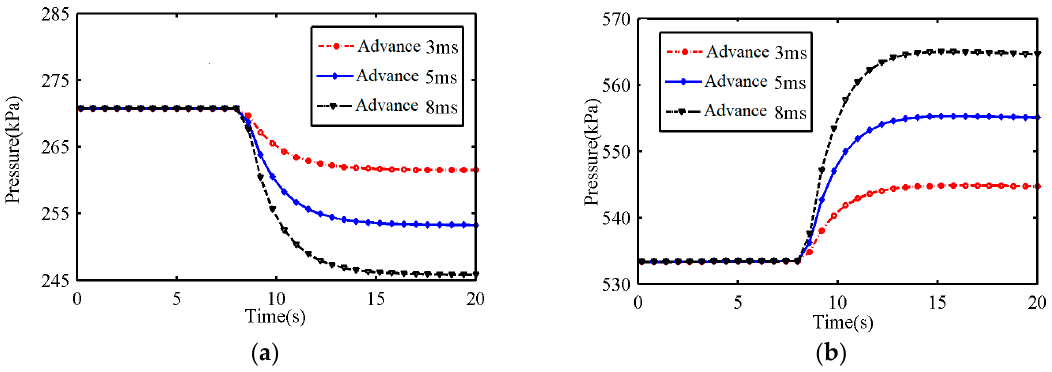
Figure 12. ( a ) First-stage exhaust buffer tank; ( b ) second-stage exhaust buffer tank. Table 4. Bu ff er tank pressure variation under di ff erent responses of the solenoid Table 4. Buffer tank pressure variation under different responses of the solenoid valve.